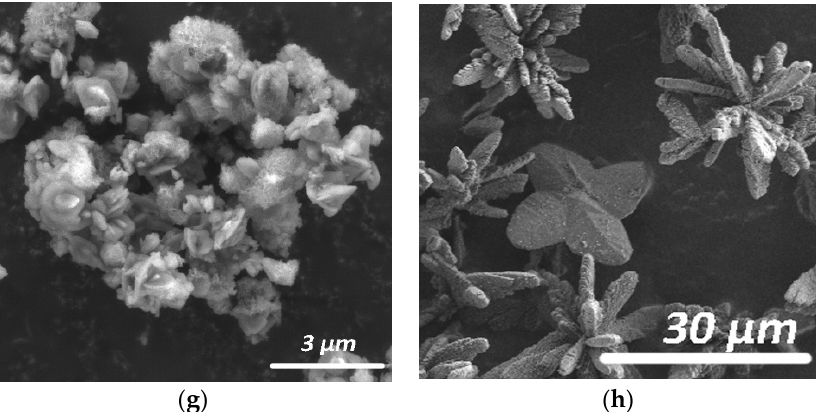
Figure 4. Morphology of weddellite crystals synthesized in the presence of various additives: ( a ) with citric acid (Synthesis 5); ( b ) with malic, fumaric and succinic acids (Synthesis 12); ( c ) with citric acid and Mg 2+ cations (Synthesis 15); ( d ) with citric acid and Fe 3+ cations (Synthesis 17); ( e ) with citric acid and Fe 3+ and SO 42 − ions (Synthesis 24); ( f ) with citric acid and carbonate ions (Synthesis 20); and ( g , h ) with citric acid and K + , Mg 2+ , Fe 3+ , SO 42 − , PO 42 − ions (Synthesis 30).